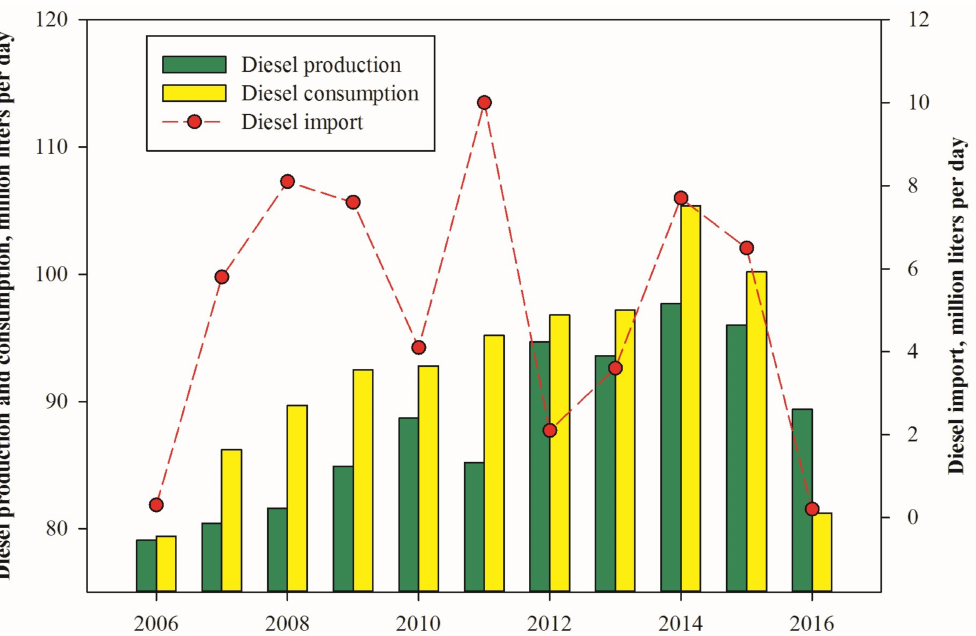
Figure 1. Diesel production, consumption, and import